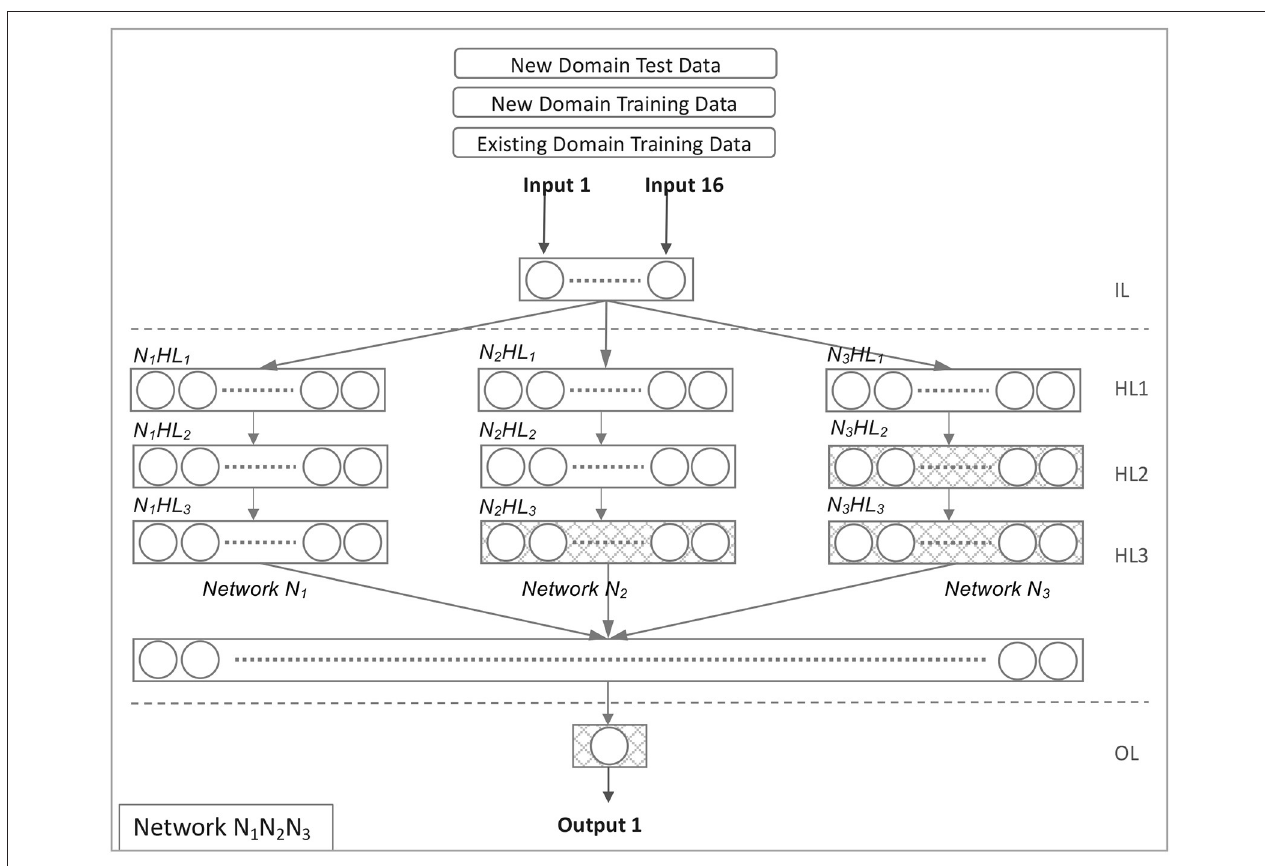
FIGURE 5 | Network N 1 N 2 N 3 .